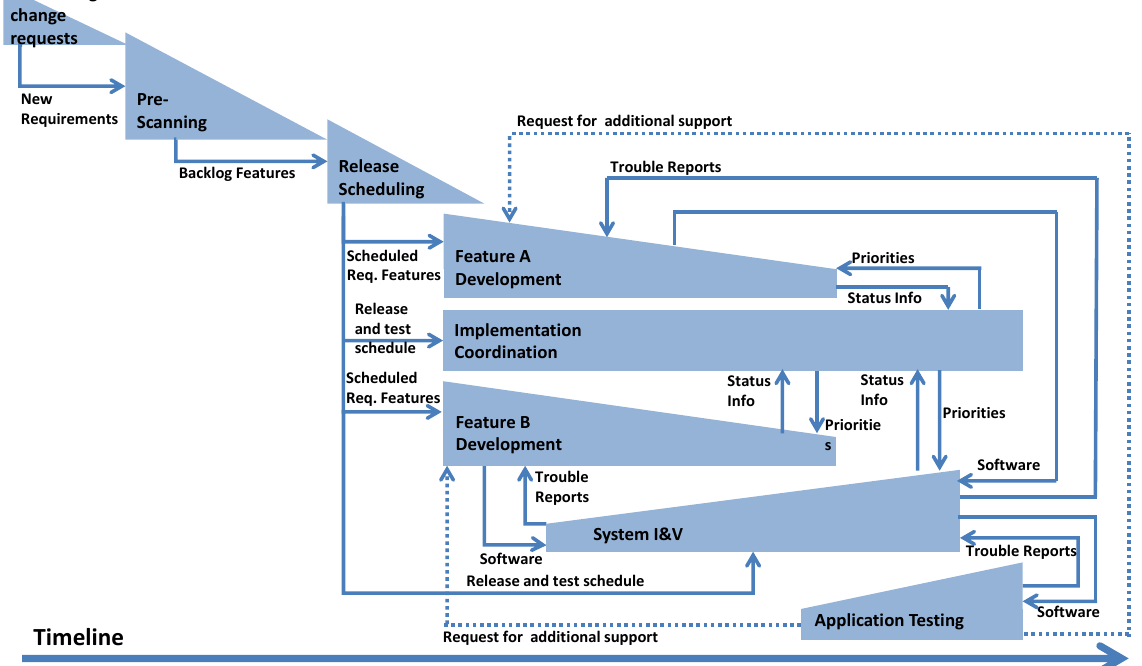
Figure 6. Timeline intensity for parallel